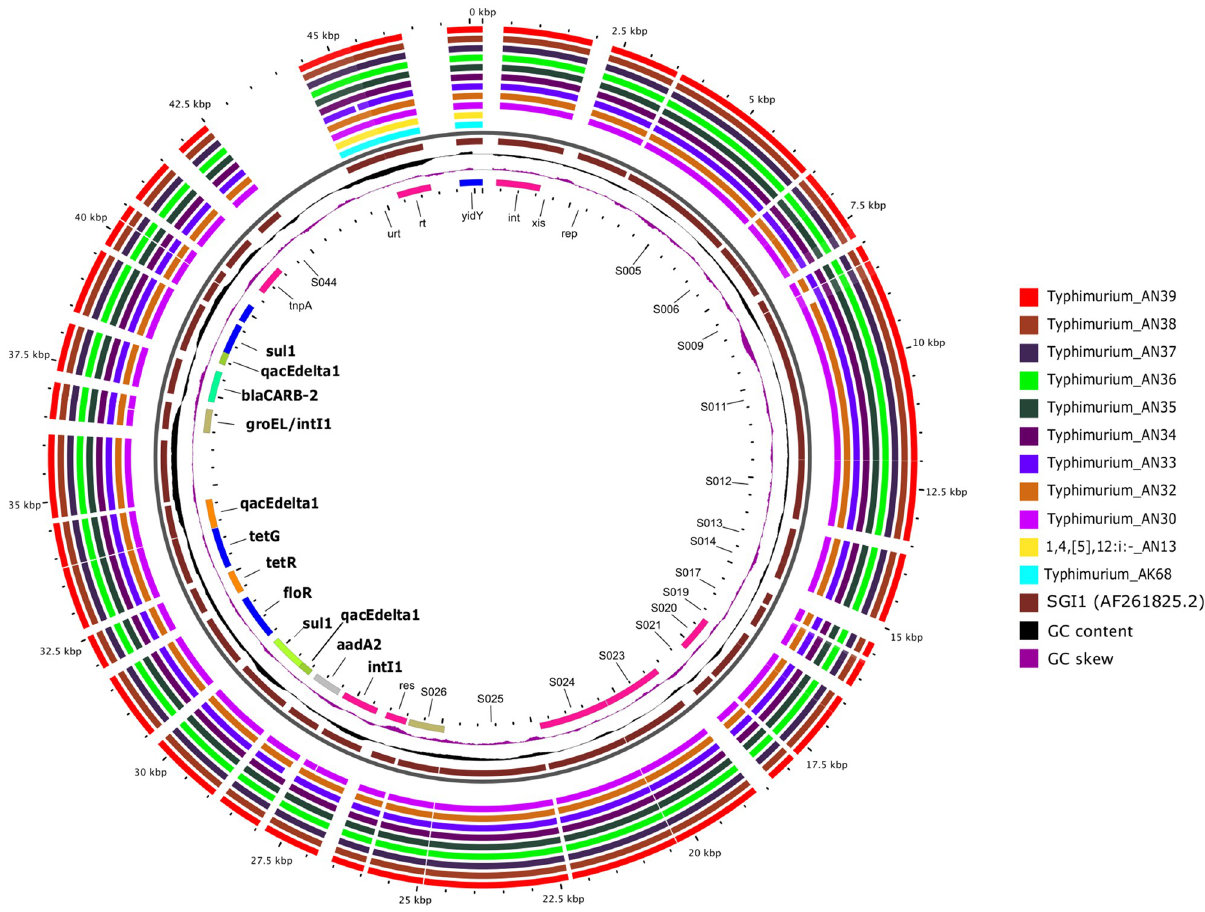
Fig 4. BLAST atlas analysis of SGI1 of 10 serovar Typhimurium isolates and one monophasic Typhimurium. The black slot corresponds to the backbone and the brown inner ring to the reference sequence. The most inner ring shows gene annotation, with AMR genes highlighted in bold text. The outer rings correspond to the serovars and isolate names indicated. Regions with shared synteny between genomes and reference sequence are filled with intense color while blank spaces indicate a lack of synteny. Refer to S1 File for accession numbers and metadata of isolates.